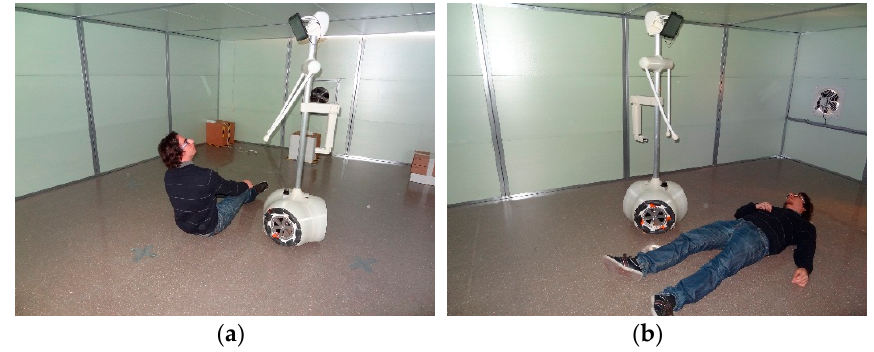
Figure 18. Simulation of the APR used as a fall detector ( a ) with activity and ( b ) without activity.